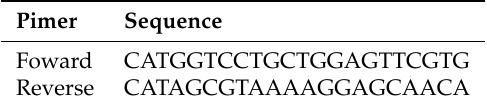
Table A2. Sense and antisense primers for seqeuncing of pEGFP–Sponge vector used for verify the presence of 8 inhibitor sequences for hsa-mir222-5p according to the manufacturer’s